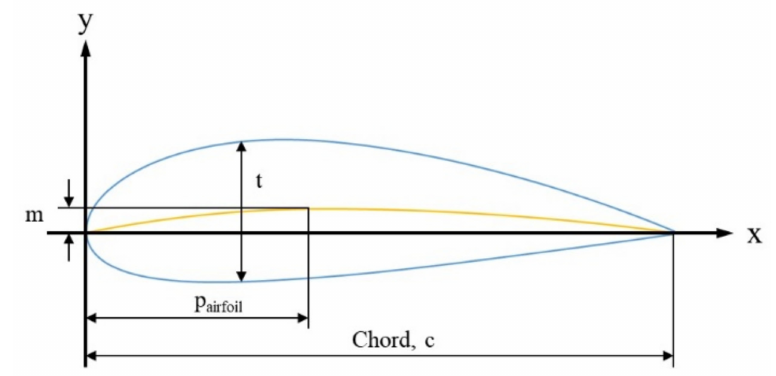
Figure 2. Parameters of the NACA 4-digit airfoil. Table 1 describes the configuration of the vane used in the study. The maximum thickness t max , scaled with the cord length (c), is 4.8%. Figure 3 shows the shapes of the vane used in the